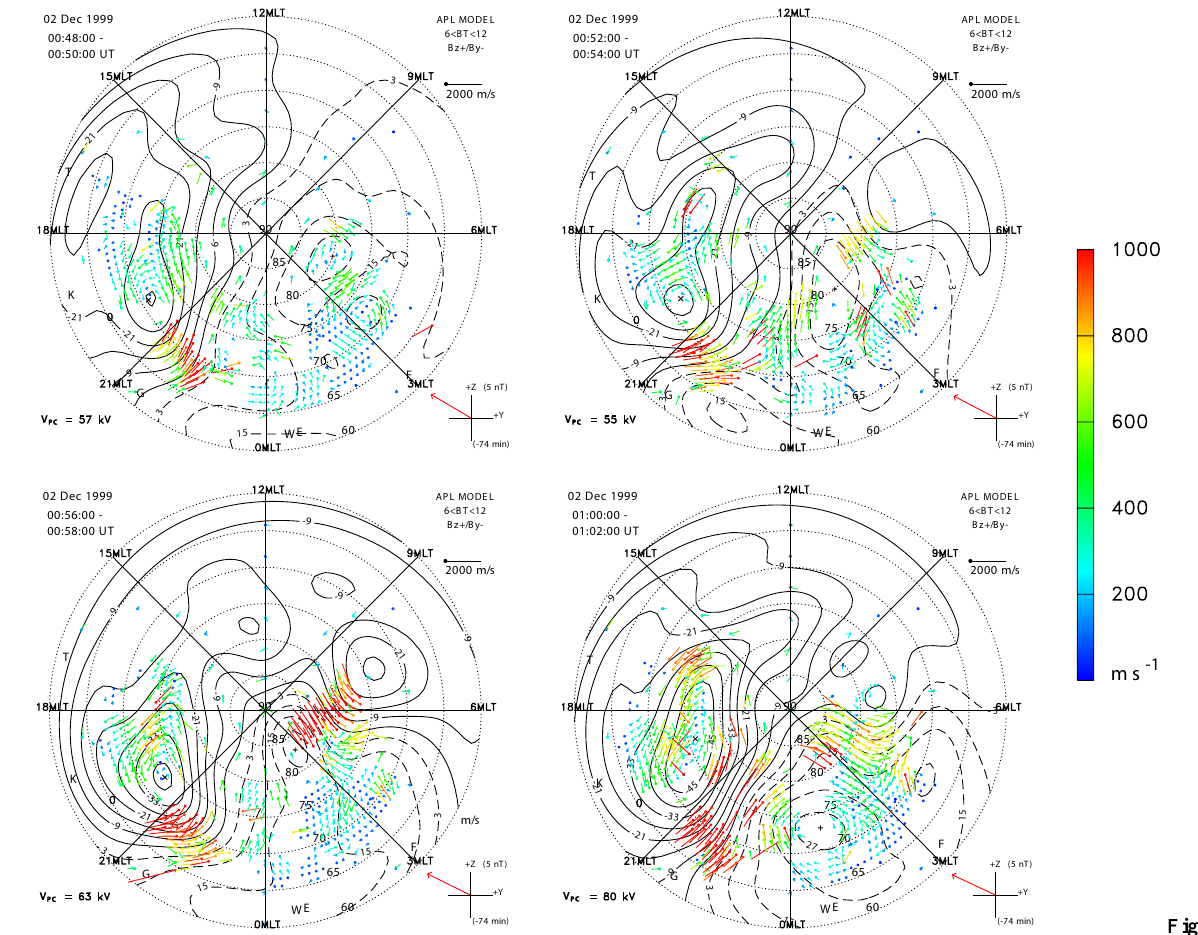
Fig. 6. Streamlines and vectors of the ionospheric flow derived from the six-radar SuperDARN velocity measurements are shown on a geomagnetic grid, obtained from the Map-Potential algorithm (see Sect. 2.1). The intervals displayed are (a) 00:32–00:46UT, (b) 00:48– 01:02UT and (c) 01:04–01:18UT on 2 December 1999. on 2 December 1999. Four maps are shown in each panel (a–c), corresponding to every other 2-min radar experiment cycle. Indicated at the bottom of each map is the total transpolar voltage V PC (left-hand corner), and the direction and magnitude (in the Y − Z plane) of the IMF (right-hand corner). In the top right-hand corner we indicate the flow model employed to stabilize the potential solution in regions where no data are available, obtained from the statistical study of Ruohoniemi and Greenwald